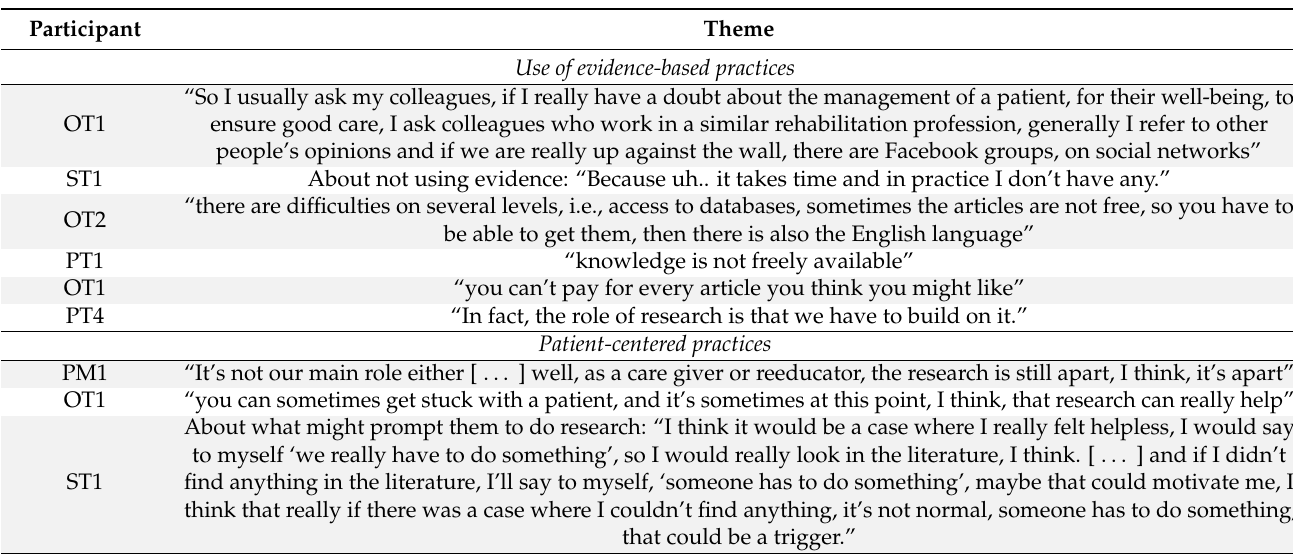
Table 5. Verbatim responses by